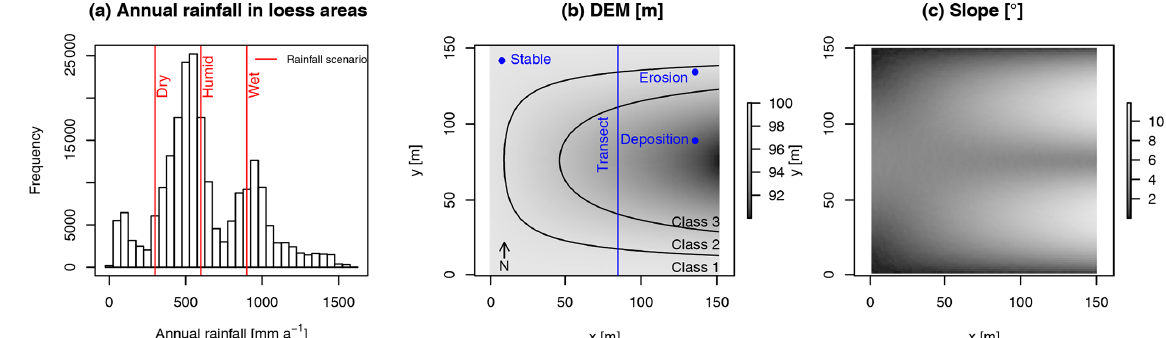
Figure 1. (a) Annual rainfall in loess areas, derived from WorldClim. Red lines indicate the rainfall scenarios in this study: 300 (dry), 600 (humid) and 900 (wet) mm per year. (b) Maps of input DEM with corresponding slope map (c) . The extent of the DEM is 150 × 150m, with a cell size of 1.5m. The different classes indicate elevation classes used in the analysis of variance (ANOVA) (Table 3). The blue dots and line indicate the location of the soil profiles and transect displayed in Figs. 2 and 3.